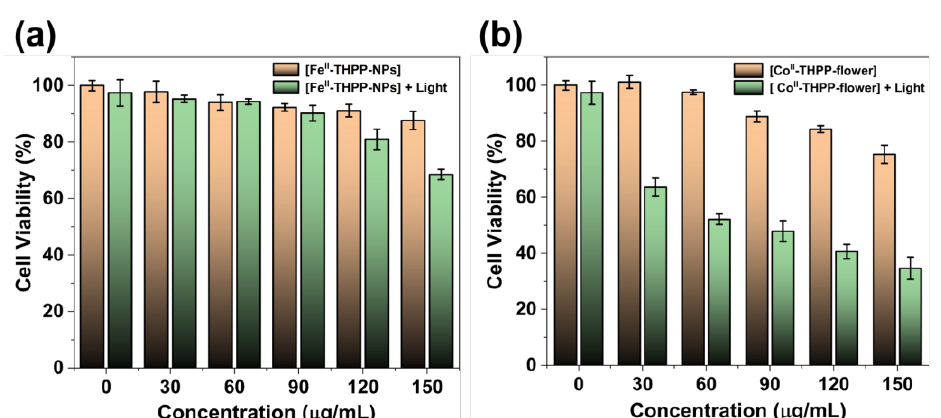
Figure 8. The cell viability of 4T1 cells treated with different concentrations of [Fe II -THPP-NPs] ( a ) and [Co II -THPP-flower] ( b ), and in the absence/presence of 660 nm laser (220 mW cm −2 ) irradiation. Data are represented as means ± SD; n = 5.